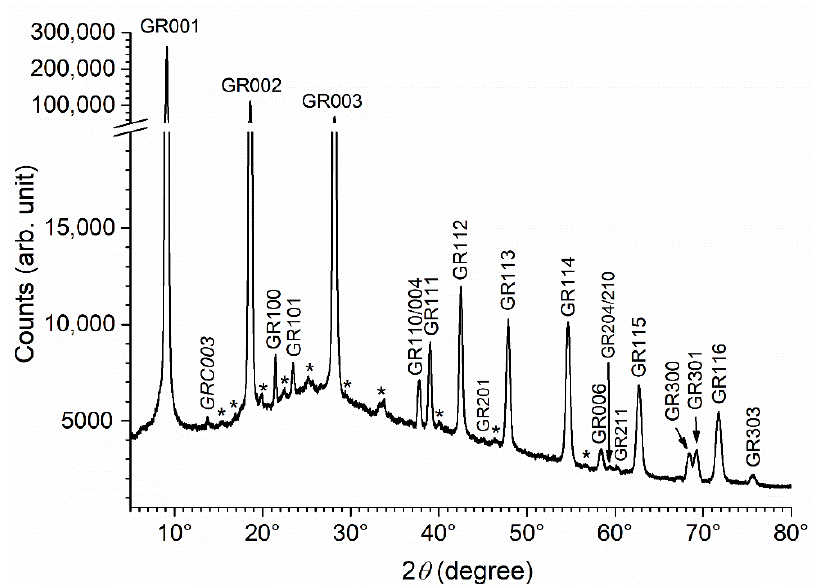
Figure 4. XRD pattern of the precipitate obtained with bacterial strain Micrococcus IVA008 after 1 week of ageing at RT. GR = GR(SO 42 − ) and GRC = GR(CO 32 − ), with the corresponding Miller index. * = unidentified peaks.